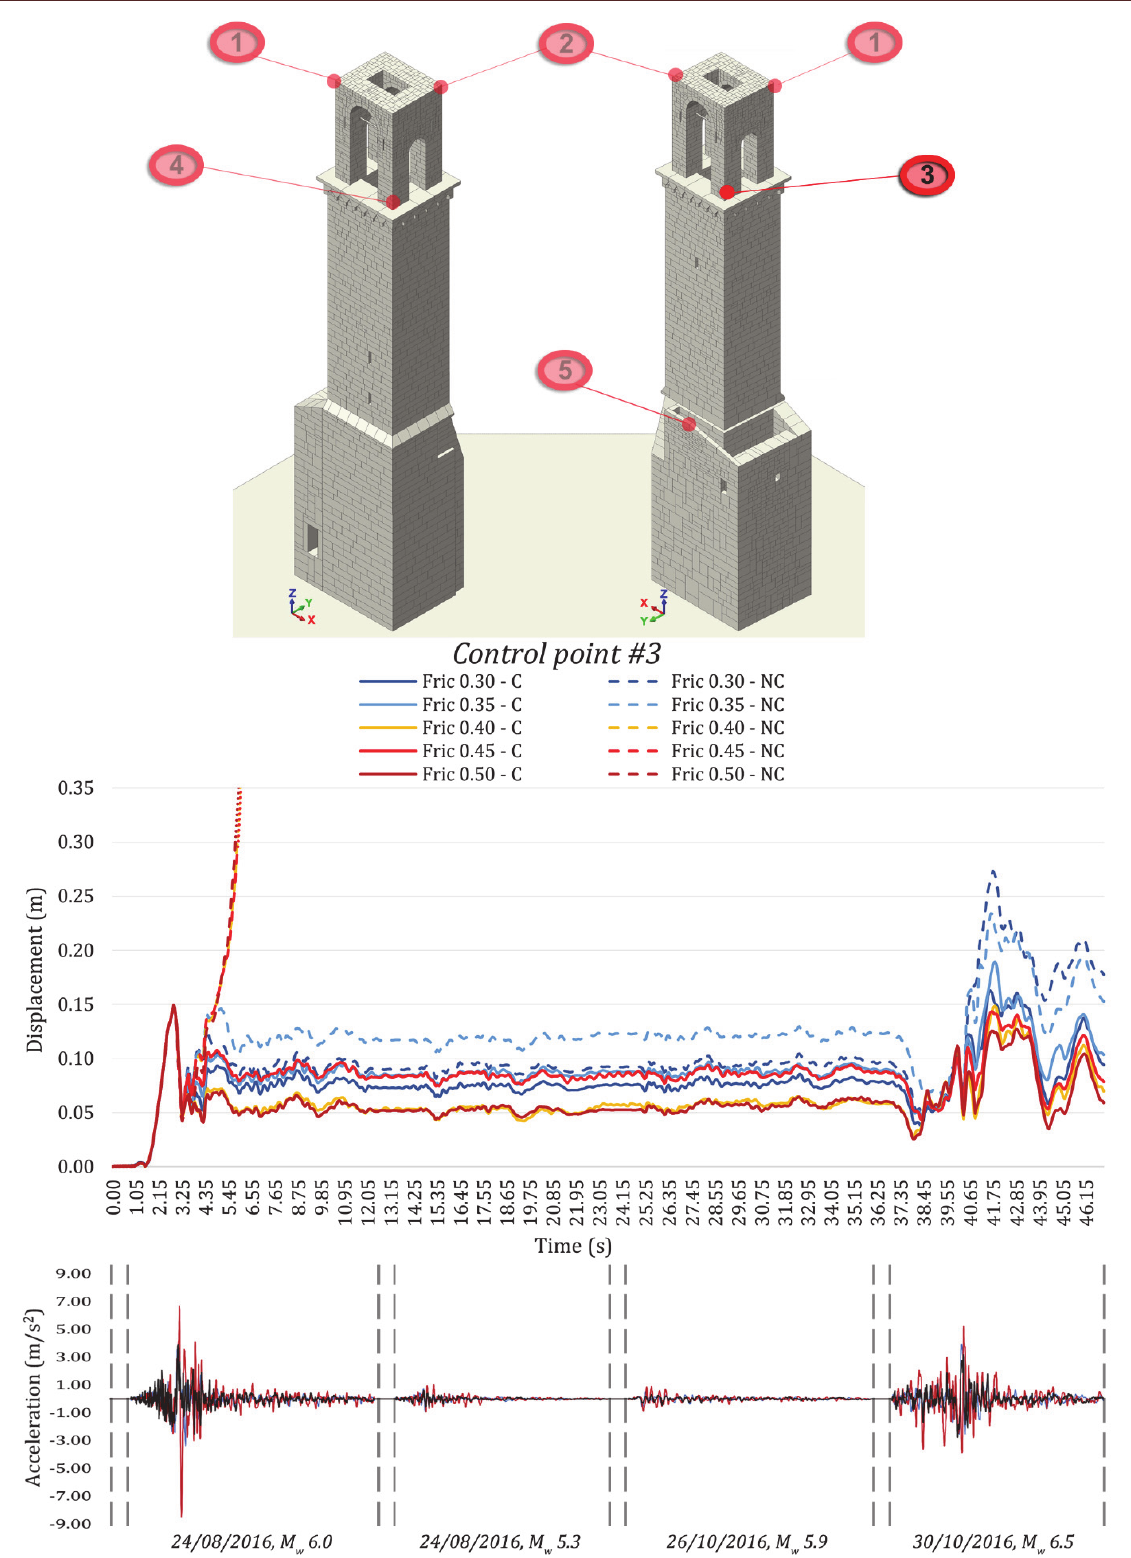
Figure 18: Displacements time histories of the control point #3 of the civic clock tower of Amatrice (Rieti, Italy) under the four main shocks in the three components x,y,z recorded in the village during the Central Italy seismic sequence of 2016 for both configurations, with (namely C) and without (NC) the steel chains, at varying of the friction on the bell